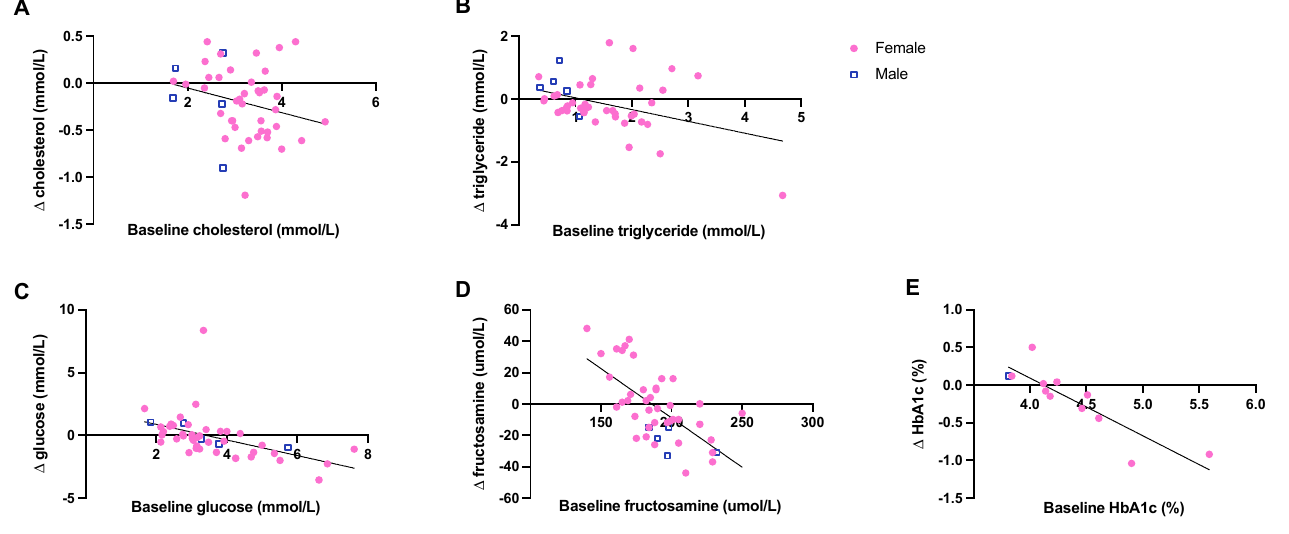
Figure 2. Effect of baseline value on delta cholesterol ( A ), delta triglyceride ( B ), delta glucose ( C ), delta fructosamine ( D ), and delta HbA1c ( E ) in full-grown adult male and female long-tailed macaques. Circles represent females; squares represent males.